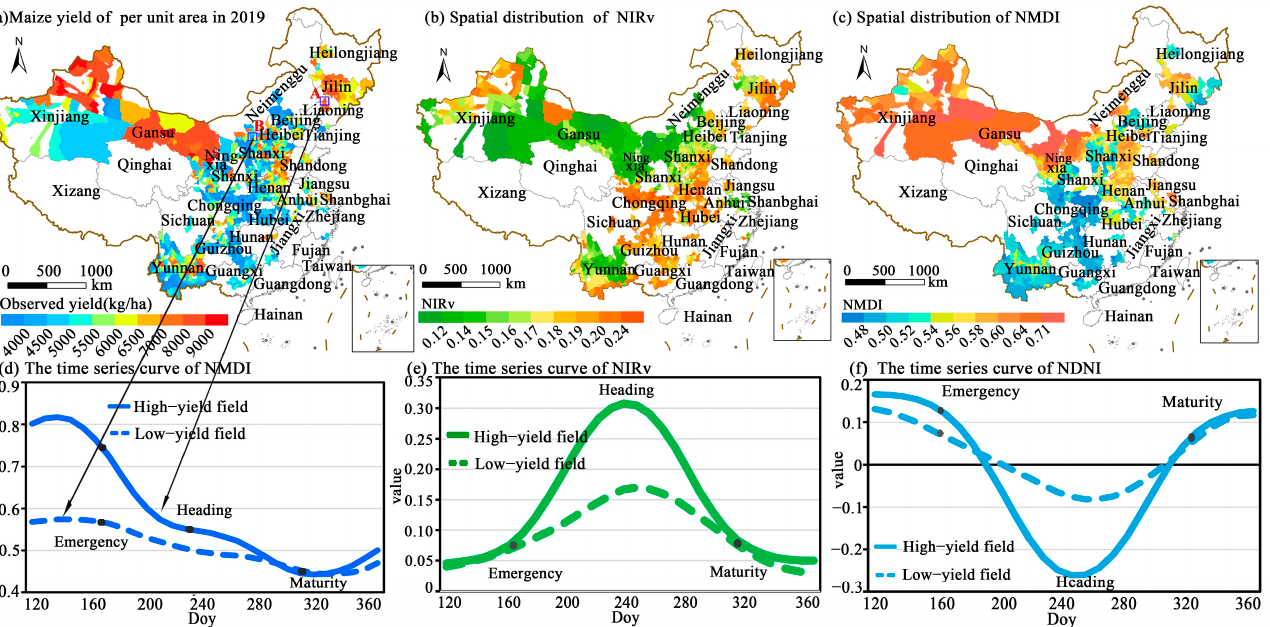
Figure 5. Relationship between yield estimation and different indexes: ( a ) spatial distribution of maize yield per unit area; ( b ) NIRv and ( c ) NMDI; change patterns of ( d ) NMDI, ( e ) CVI and ( f ) NDNI with yield in 2019. Note: ( d – f ) show the time series curves of the high-yield fields in Kangning County, Liaoning City and Liaoning Province (yield = 8808 kg/ha) and the low-yield fields in Pianguan County, Shanxi City and Shanxi Province (yield = 3723.3708 kg/ha)